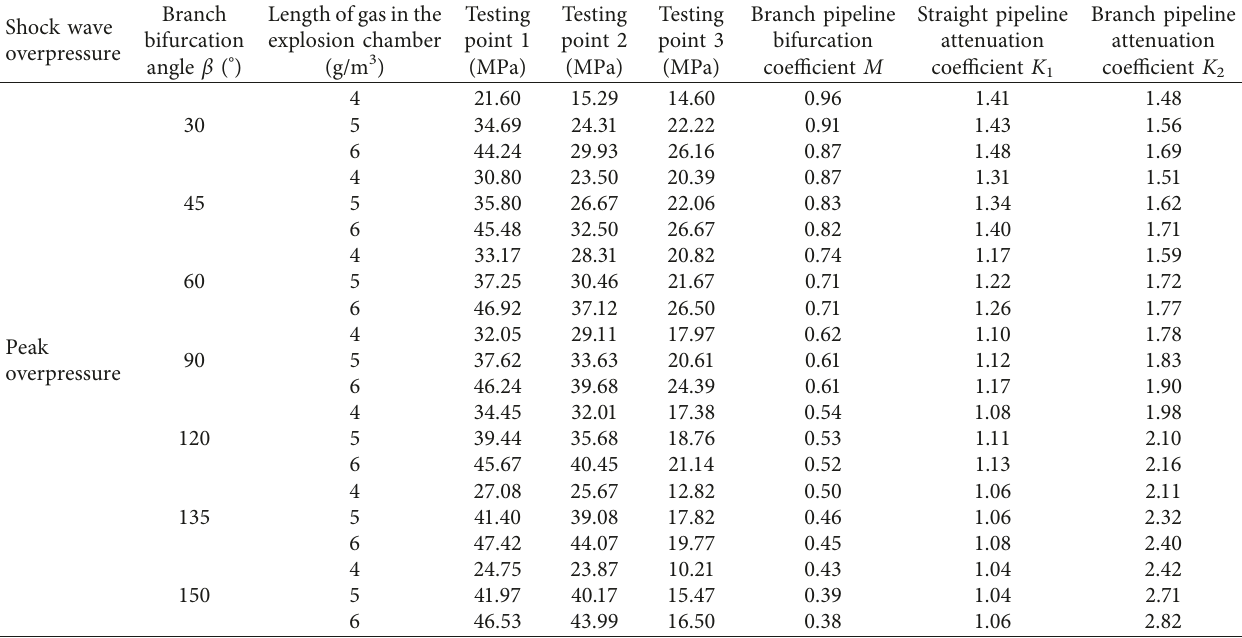
Table 1: Coefficient shunt and attenuation coefficient of the gas explosion shock wave via the one-way bifurcation pipeline. Shock wave overpressure